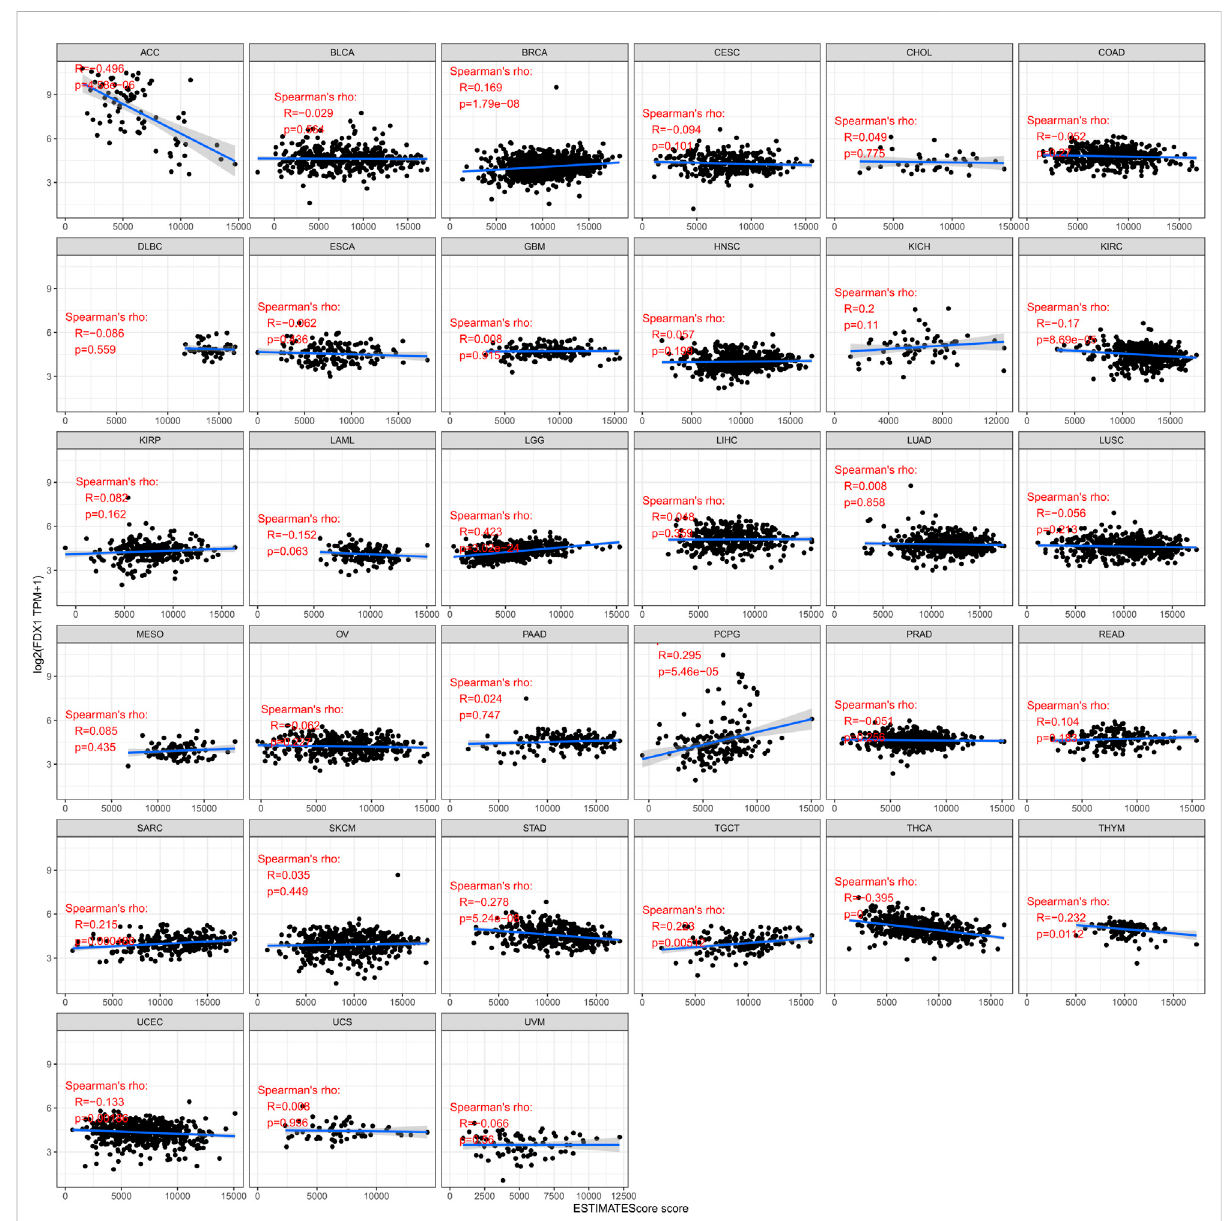
FIGURE 6 Correlation of FDX1 expression with ESTIMATEScore score in